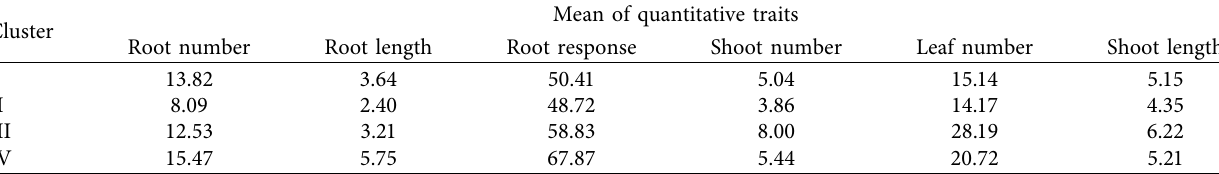
Table 9: Mean of the quantitative traits for each cluster of sesame